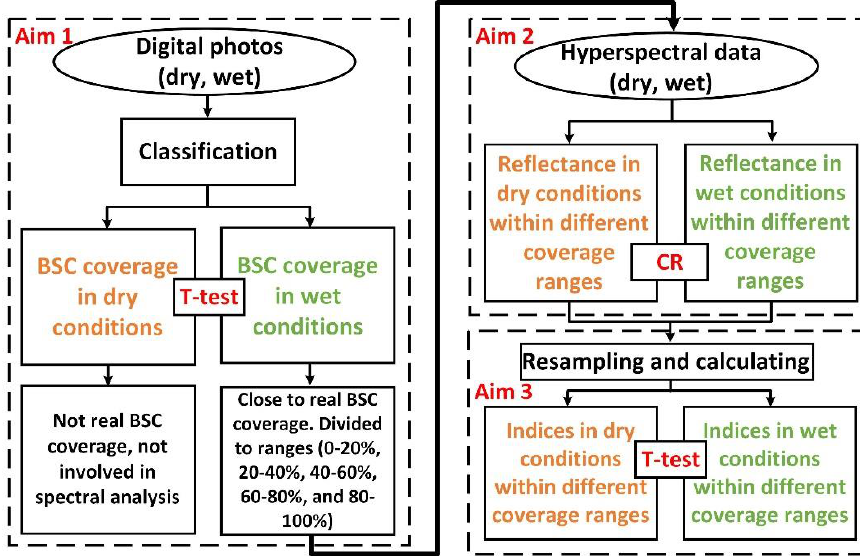
Figure 4. Flow chart of the study process.